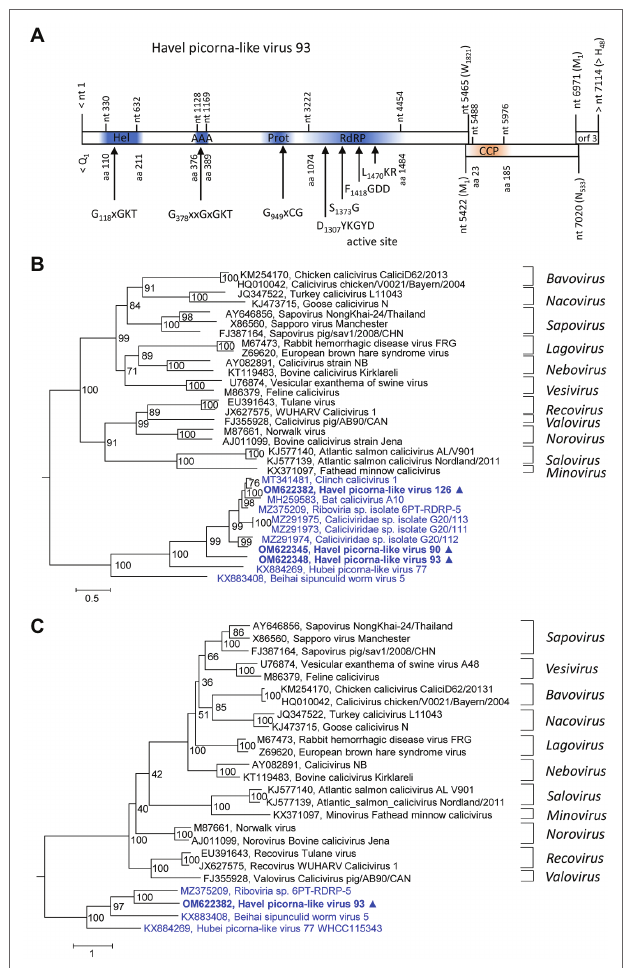
FIGURE 2 | Analysis of new caliciviruses. (A) The genome organization of Havel picorna-like virus 93 resembles the calicivirus genome. ORF1 shows conserved elements of helicase (Hel), proteinase (Prot), and polymerase (RdRP) domains, whereas ORF2 has similarity to the calicivirus capsid protein (CCP) family of caliciviruses. Conserved domains and sequence motifs were identified by searching the NCBI Conserved Domain Database (https://www. ncbi.nlm.nih.gov/Structure/cdd/wrpsb.cgi). Phylogenetic analyses of the VP1 (capsid protein) gene region (B) and the proteinase/polymerase gene region (C) of calicivirus prototype strains, unassigned caliciviruses, and Havel picorna-like viruses 93, − 175, and − 176 are shown. The trees were inferred with IQ-Tree 2, optimal substitution model: TVM + F + R4 (B) and TVMe+R4 (C) . Numbers at nodes present bootstrap values obtained after 50,000 ultrafast bootstrap replications. The scale indicates substitutions per site. Presented are GenBank acc. nos. and virus names. The respective genera are indicated to the right. Unassigned viruses are printed in blue. A triangle ( ▲ ) indicates the viruses of the present study. AAA, AAA protein with homology to ATPase family associated with various cellular functions, Hel, helicase, Prot, proteinase; RdRP, polymerase; and CCP, capsid protein with similarity to the calicivirus capsid